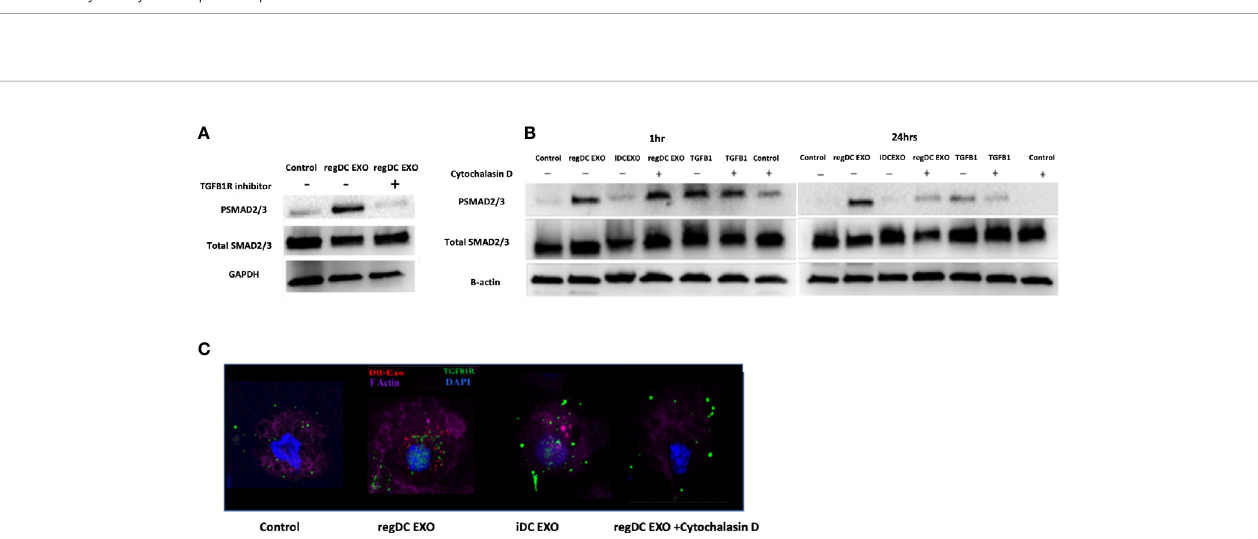
FIGURE 10 | Early and sustained pSMAD2/3 signaling by uptake of regDC EXO with TGF b RI: (A) Immunoblot of Psmad2/3 and total smad2/3 in recipient DCs co-cultured for 24 h with reg DCS EXO +/- TGF b 1R inhibitor SB431542. Loading control was GAPDH (B) Immunoblot of Psmad2/3 and total smad2/3 in recipient DCs co-cultured for 1 and 24 h with reg DC EXO or iDC EXO +/- cytochalasin D. Loading control was B-actin. (C) Uptake of Dil labeled EXO (red) by recipient DCs, DAPI (blue), Alexa Fluor 680 phalloidin (violet) for FActin, Alexa fl our 488 (green)-mouse anti-TGF b R1, visualized under confocal microscopy. Dil-DCs EXO or no EXO were added to recipient DCs at a 10:1 EXO : DC ratio (24 h shown). Results shown are representative of three independent